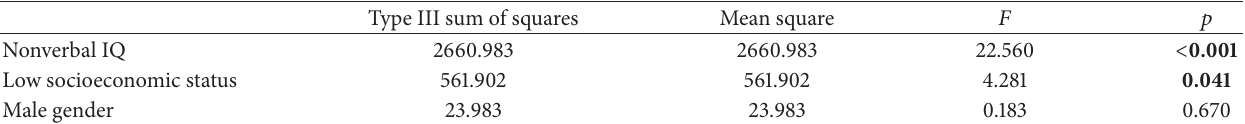
Table 5: Variables associated with BNT score improvement from year to year, in multivariate general linear model with repeated measures (longitudinal analysis).